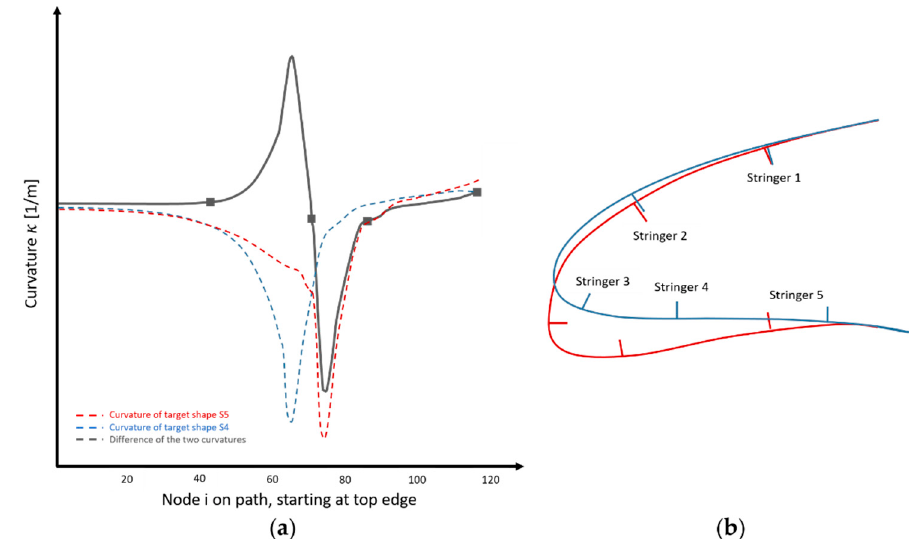
Figure 8. Curvature analysis for placement of stringers (schematic); ( a ) abscissa: Location along the MLE-contour; blue: Curvature along contour S4, red: Curvature along contour S5, grey: Difference between S4 and S5 curvatures, grey squares: Selected locations for stringers 2 to 5 (region of stringer 1 does not change curvature very much anyhow); ( b ) Blue curve is S4, red curve is S5 (not to scale).